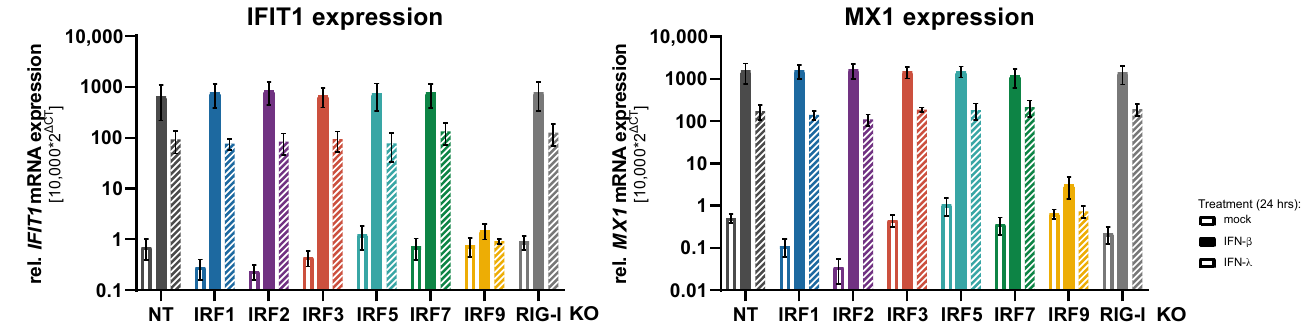
Figure 2. Impact of IRF KO on ISG induction upon IFN treatment. A549 NT , A549 IRF (as indicated) KO , and A549 RIG-I KO cells were stimulated with IFN- β (500 IU/mL) or IFN- λ (5 ng/mL) for 24 h. Relative IFIT1 and MX1 mRNA levels were measured by qRT-PCR. Data show the mean ± SD of three independent